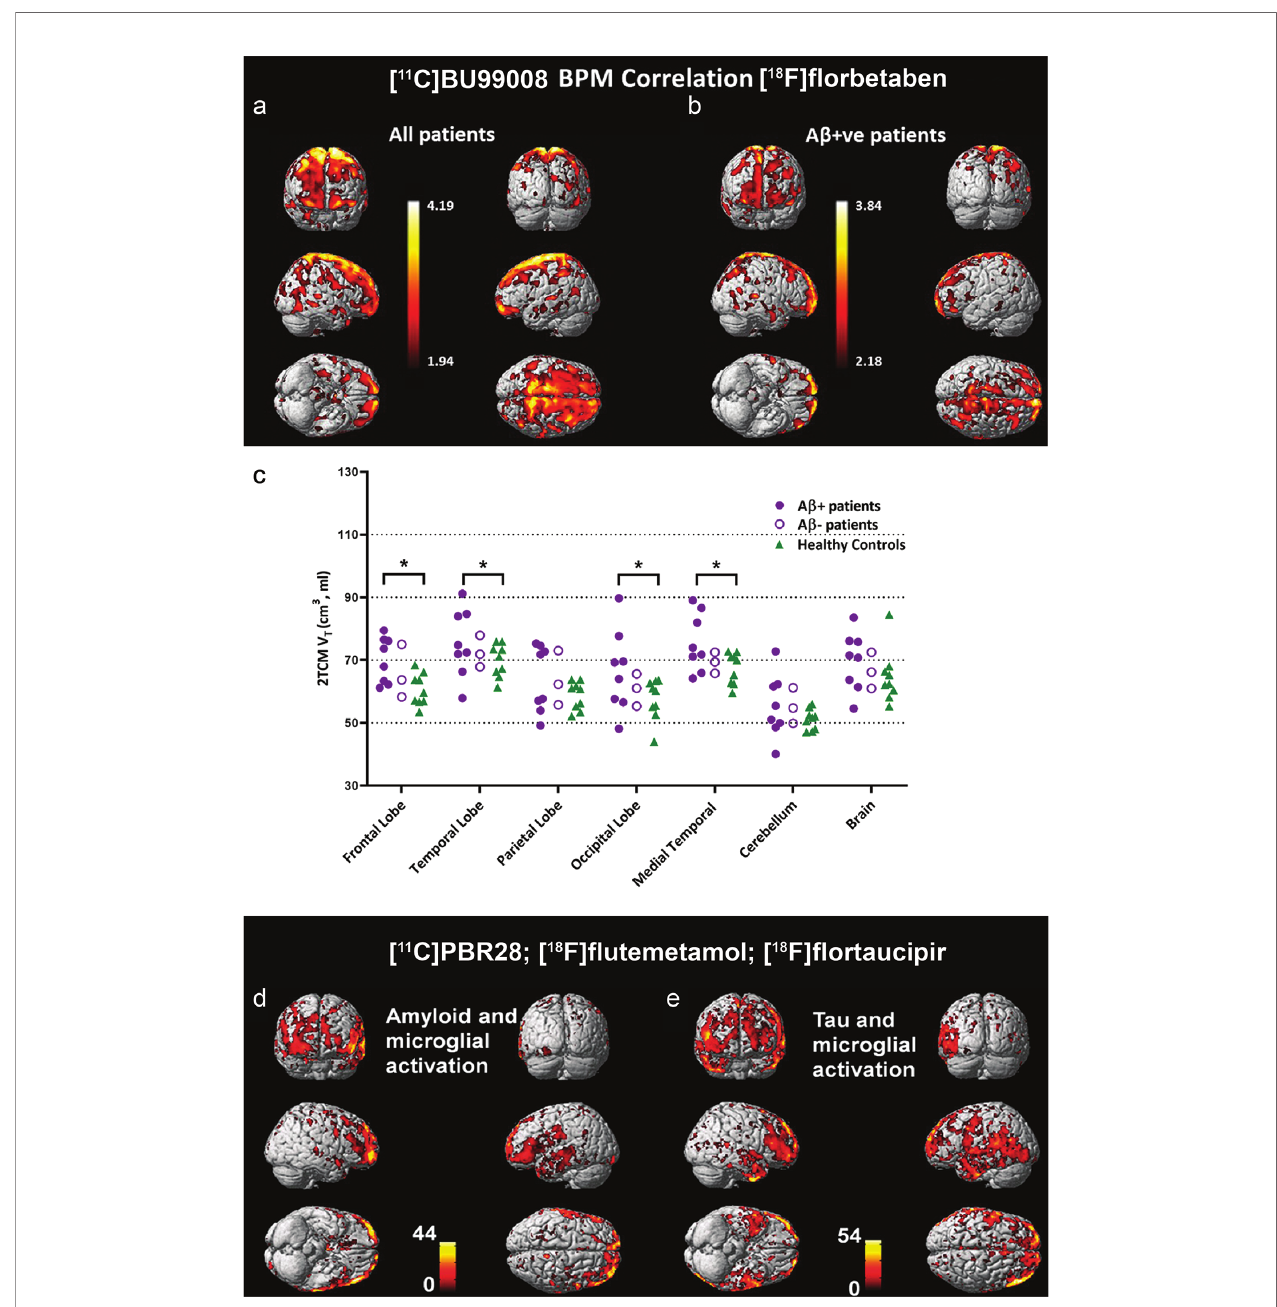
FIGURE 2 | Biological parametric mapping (BPM) correlation between [ 11 C]BU99008 and [ 18 F] fl orbetaben binding in (A) all cognitively impaired (CI) subjects and in (B) A b -positive cognitively impaired subjects at a cluster threshold of p <0.05 with an extent threshold of 50 voxels. These BPM are T maps describing the strength of the voxel-wise correlations between binding of the two radioligands represented in a common brain space. (C) Dot plot demonstrating the regional [ 11 C]BU99008 total volumes of distribution (Vt) using two-tissue compartmental models in A b -positive cognitively impaired subjects (purple fi lled circle), A b -negative CI subjects (purple open circle), and healthy controls (HC, green triangle). “ Brain ” refers to the composite cortex, combining all the major cortical regions. * p <0.05, uncorrected. Reproduced from (176) with permission from Springer Nature. (D, E) Voxel-level correlation between [ 18 C]PBR28, [ 18 F] fl orbetapir, and [ 18 F] fl utemetamol in the patients with mild cognitive impairment and Alzheimer ’ s disease who were positive for all three tracers. (D) Voxel-level correlations between microglial activation assessed by using [ 18 C]PBR28 and tau aggregation assessed by using [ 18 F] fl orbetapir. (E) Voxel-level correlations between microglial activation assessed by